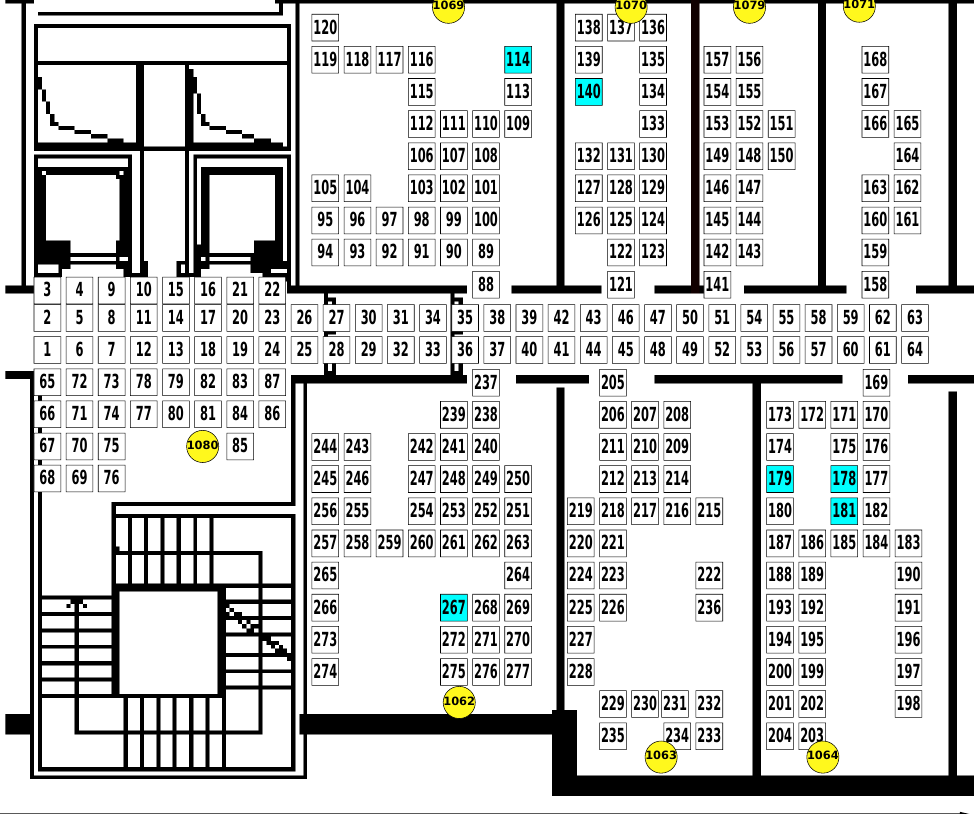
Figure 1. Grid layout for the test environment. Each point has X, Y